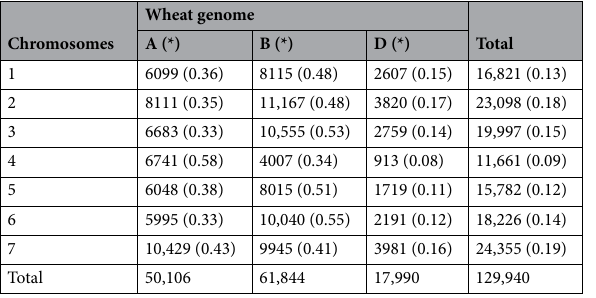
Table 2. Distribution of SNP markers across the A, B and D genomes. *Proportion of markers on a homoeologous group of chromosomes that were contributed by a single sub-genome.